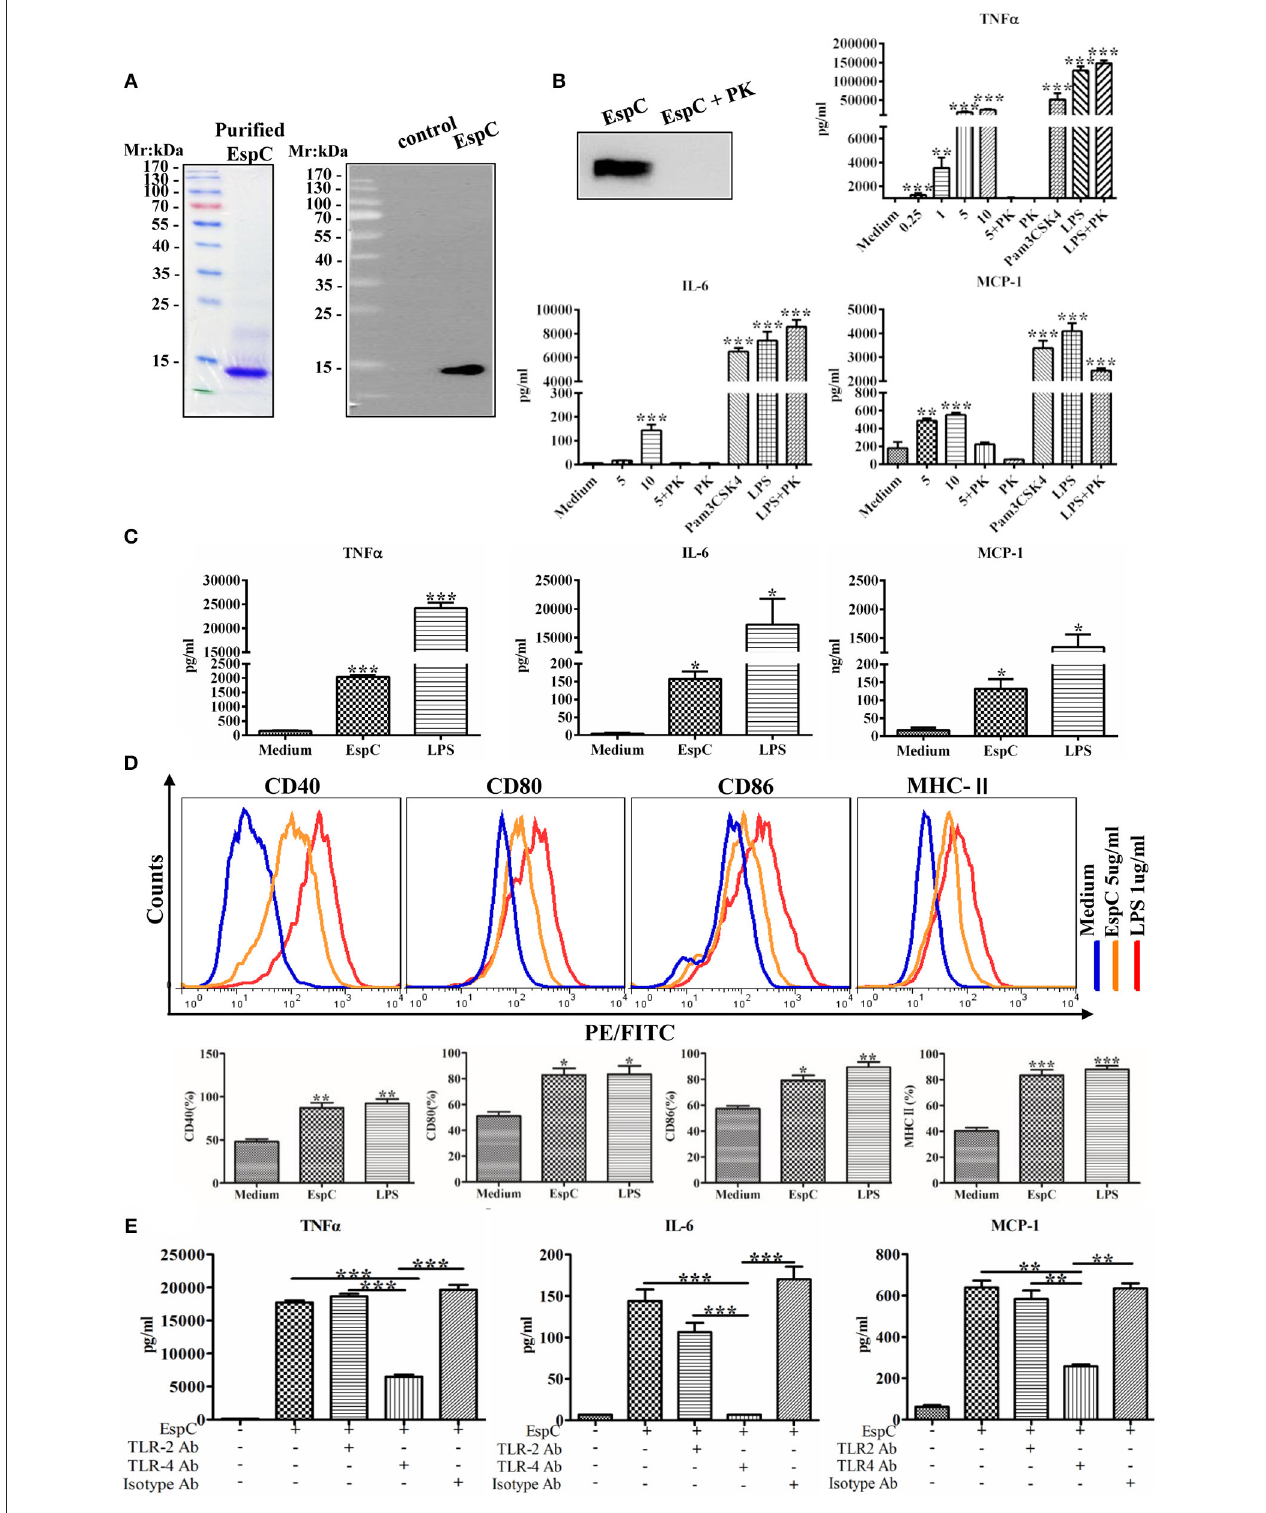
FIGURE 1 | EspC induced cytokine secretion and the production of costimulatory and MHC-II molecules in macrophages. (A) The protein was expressed in Escherichia coli and purified by Ni-NTA affinity chromatography. The purified protein was subjected to SDS-PAGE analysis by staining with Coomassie blue or to